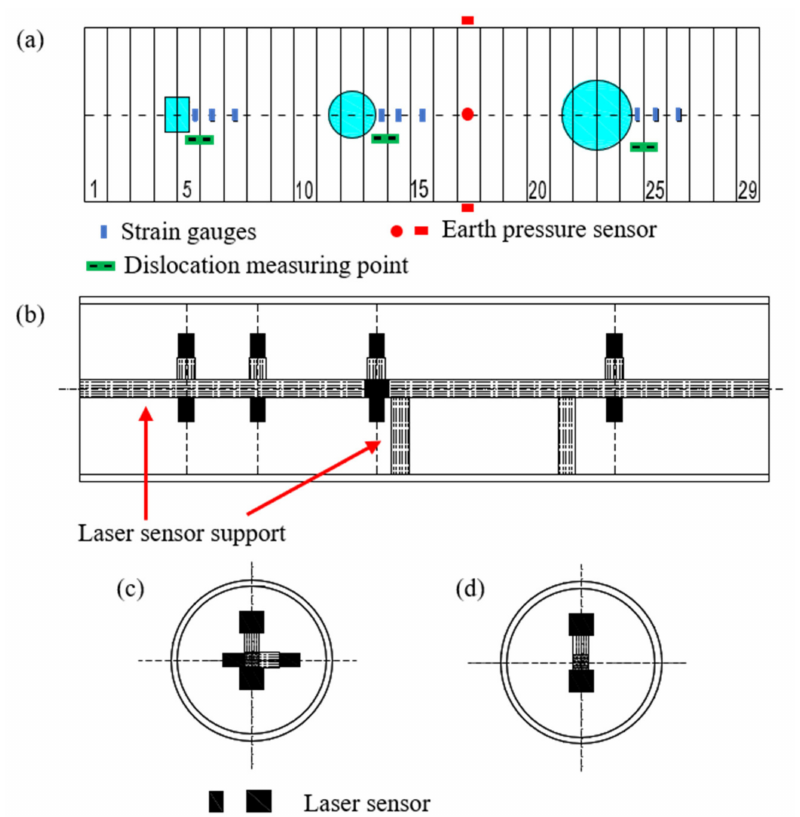
Figure 6. Schematic diagram of monitoring scheme: ( a ) layout of the openings, strain gauges, and earth pressure sensors; ( b ) layout of the laser sensors and support in the front view; ( c ) layout of the laser sensors and support in the side view for SC-Op; ( d ) layout of the laser sensors and support in the side view for other